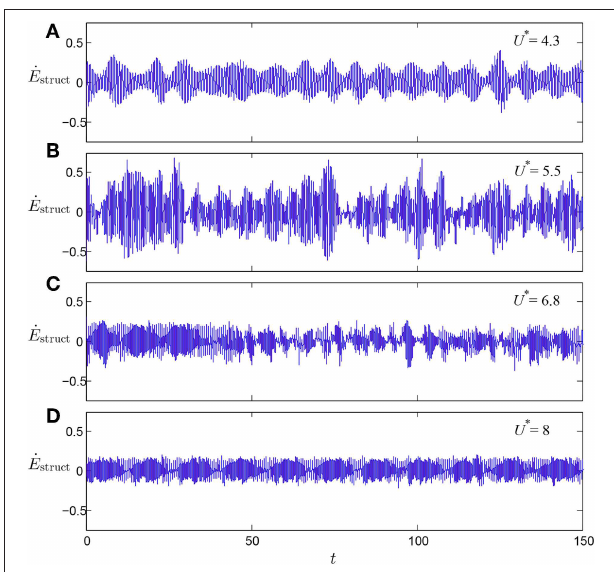
FIGURE 7 | Time series of the rate of energy transfer from the fluid to the structure at different reduced velocities: (A) U ∗ 6.8, (D) 8. =